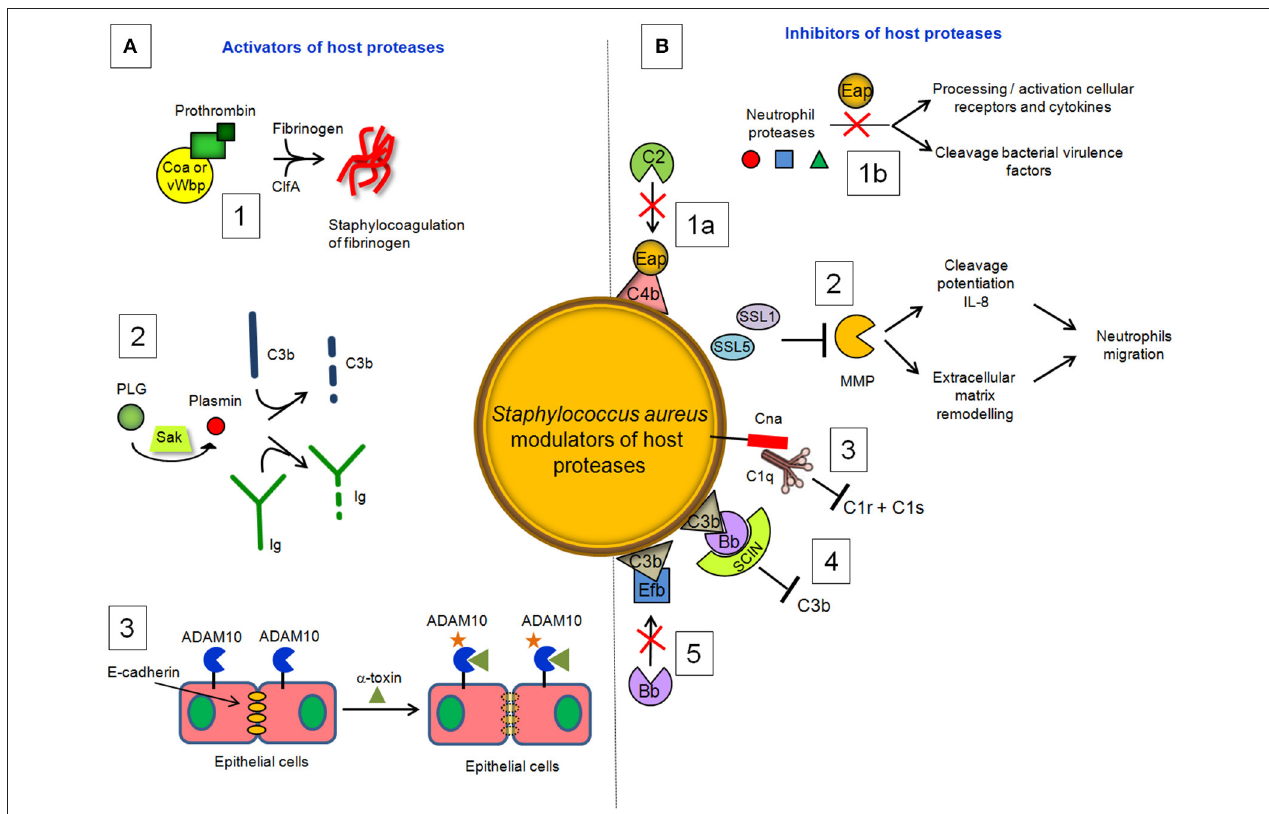
FIGURE 4 | S. aureus modulators of host proteases. (A) Activators. (1) Coa and vWbp activate prothrombin to cleave fibrinogen, whereas clumping factor A allows staphylococci to associate to form fibrin cables. (2) The plasminogen (PLG) binding protein staphylokinase (SAK) activates the zymogen to the active protease plasmin, which can degrade complement opsonin C3b and the immunoglobulin Fc domain. (3) α -toxin binds to the ADAM10 receptor to disrupt the physiological barrier functions of tissues such skin. (B) Inhibitors. (1a) Extracellular adherence protein ( Eap ) disrupts formation of the CP/LP C3 proconvertase (C4bC2) by preventing C4b from binding to C2, inhibiting formation and deposition of C3b on the surface of S. aureus cells. (1b) Eap specifically inhibits neutrophil serine proteases elastase, proteinase 3 and cathepsin G, by blocking processing and activation of cellular receptors and chemokines and cleavage of bacterial virulence factors. (2) Superantigen-like protein 1 (SSL1) and 5 (SSL5) prevent matrix metalloprotease (MMP)-induced cleavage of IL-8, a chemokine produced by macrophages and other cell types that induces neutrophil chemotaxis, and inhibit the remodeling of extracellular matrix and the consequent migration of neutrophils through collagen. (3) Collagen adhesin (Cna) blocks the association of C1q bound to immunoglobulin with complement component C1r and inhibits the classic pathway formation. (4) The secreted peptide S taphylococcal Complement Inhibitor (SCIN) stabilizes C3bBb convertase of the alternative pathway in an inactive form, preventing the production of C3a, C3b, and C5a. (5) The e xtracellular fibrinogen binding protein (Efb) induces a conformational change in C3b in a way that impairs its interaction with complement factor B and formation of the active C3 convertase of the alternative